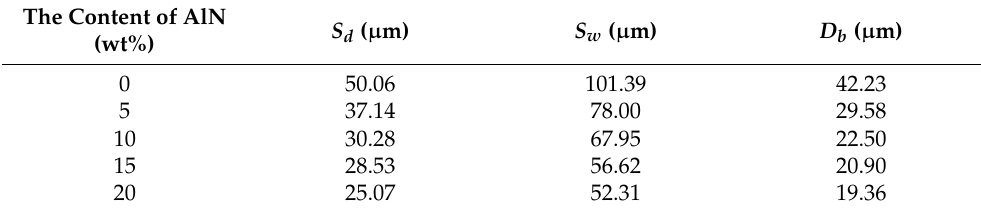
Table 1. Depth sensitivity ( S d ), width sensitivity (S w ), and broadening depth ( D b ) of the suspensions with different AlN content.